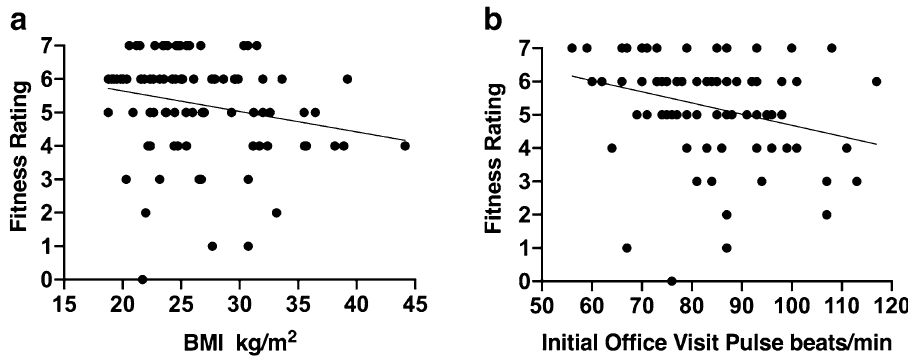
Figure 1. Fitness ratings negatively correlated with BMI and initial office pulse. ( A ) Regression scatter plot between fitness rating and BMI (kg/m 2 ). Fitness rating decreased 0.061 per kg/m 2 (F(1,86) = 4.149, p < 0.05), R 2 0.046. ( B ) Regression scatter plot between fitness rating and initial office pulse (beats/min). Fitness rating decreased 0.0336 for each beat/min (F(1,87) = 7.677, p < 0.05), R 2 0.081. Data from 3-min 9-in. At Pace group shown.